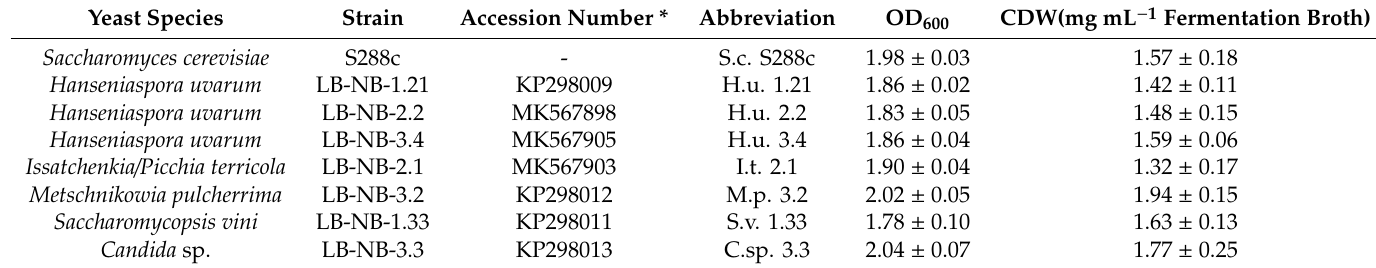
Table 1. A list of yeasts included in the dataset. Values (Mean ± SD) of optical density at 600 nm (OD 600 ) and cell dry weight (CDW) of the fermentation broths (n = 6) are